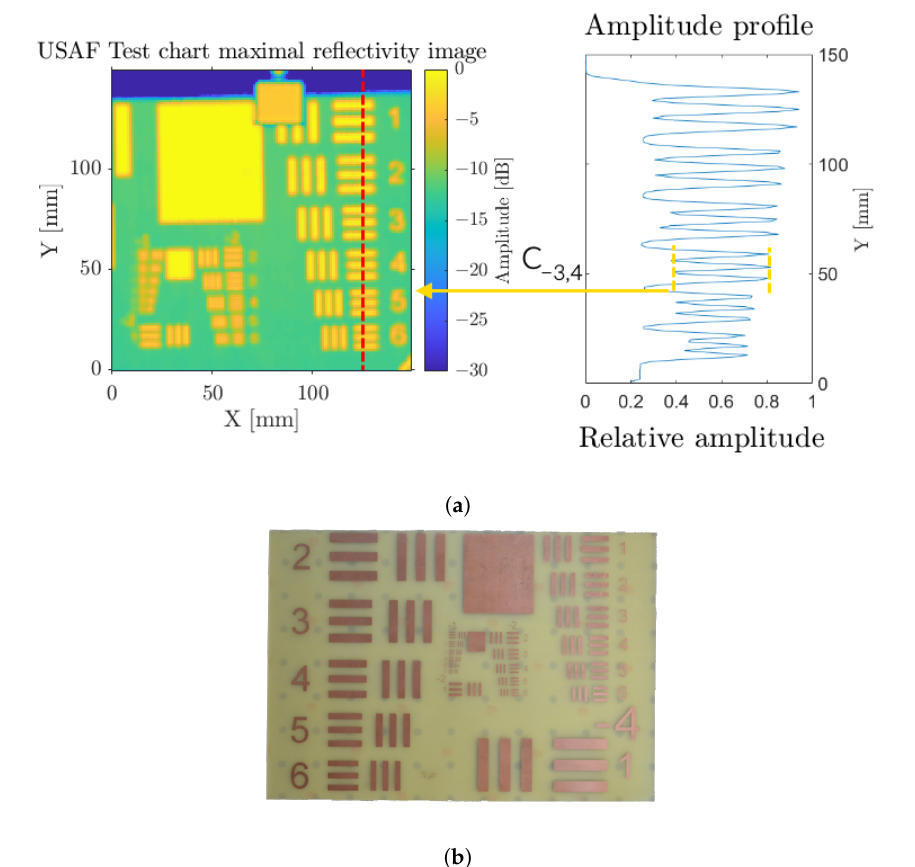
Figure 4. Estimation of the lateral resolution using a 1951-USAF test chart. ( a ) Radar maximal reflectivity image and amplitude profile on a line; ( b ) photography of the USAF test